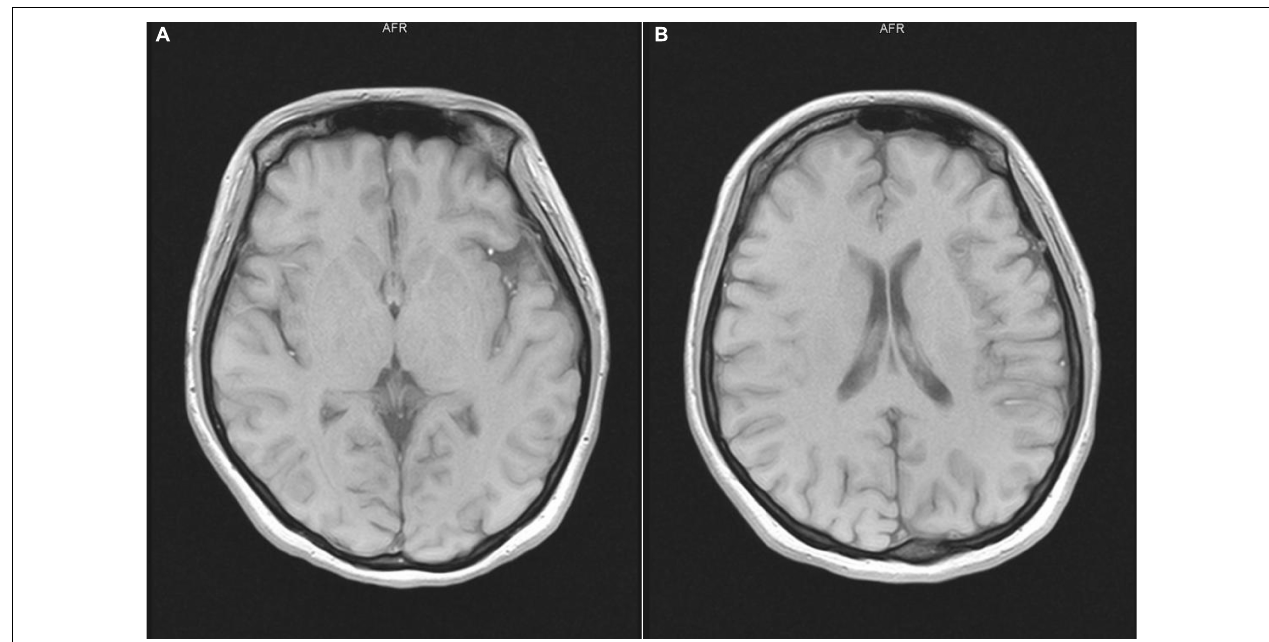
FIGURE 1 | Cranial magnetic resonance scan showed microischemia on the bilateral frontal lobe. (A,B) show that different sections of the patient’s head MRI are